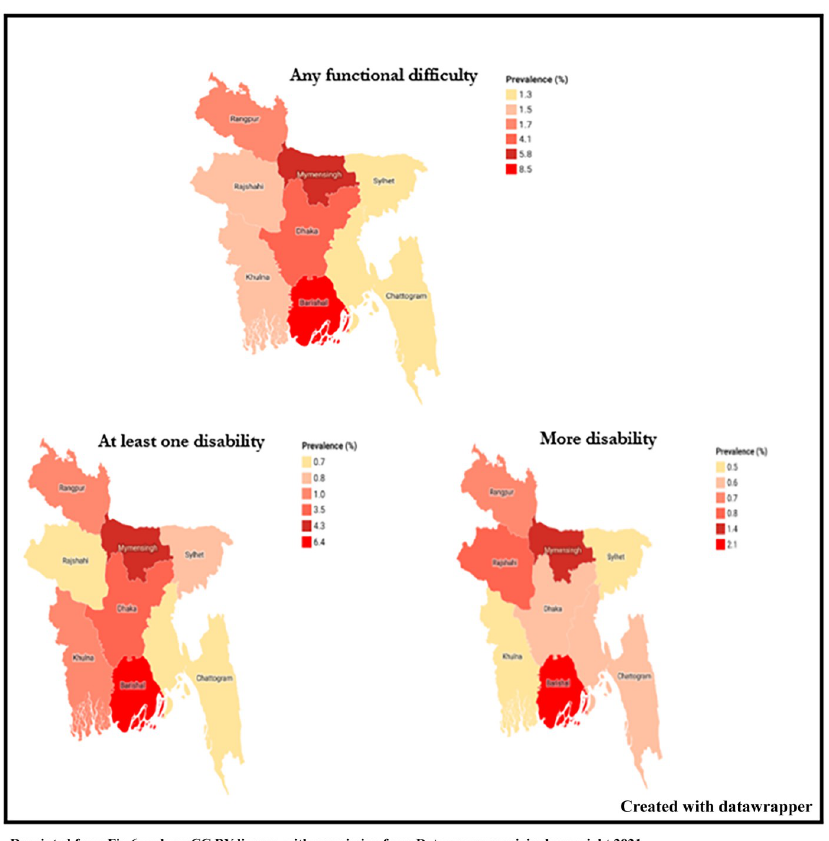
Fig 6. Divisional variation in the prevalence of different types of disability (any functional difficulty, at least one disability to more disability) among under-five children in Bangladesh.